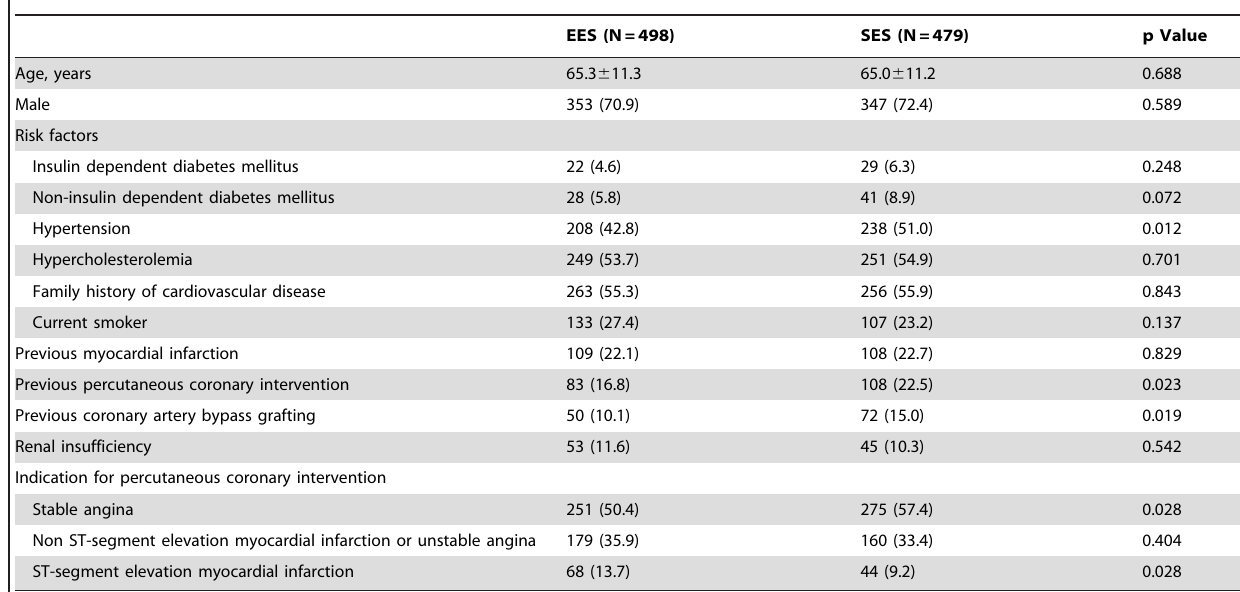
Table 1. Baseline